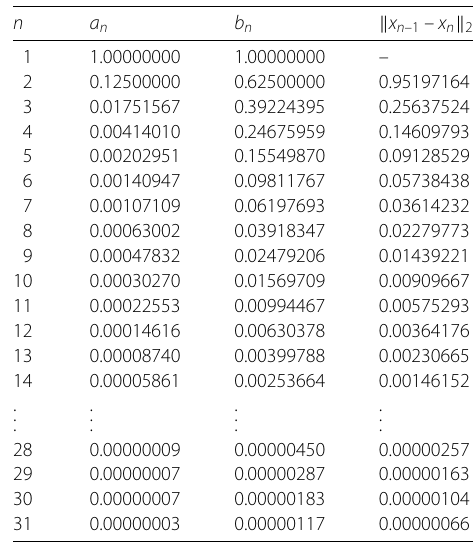
Table 1 Numerical experiment for x